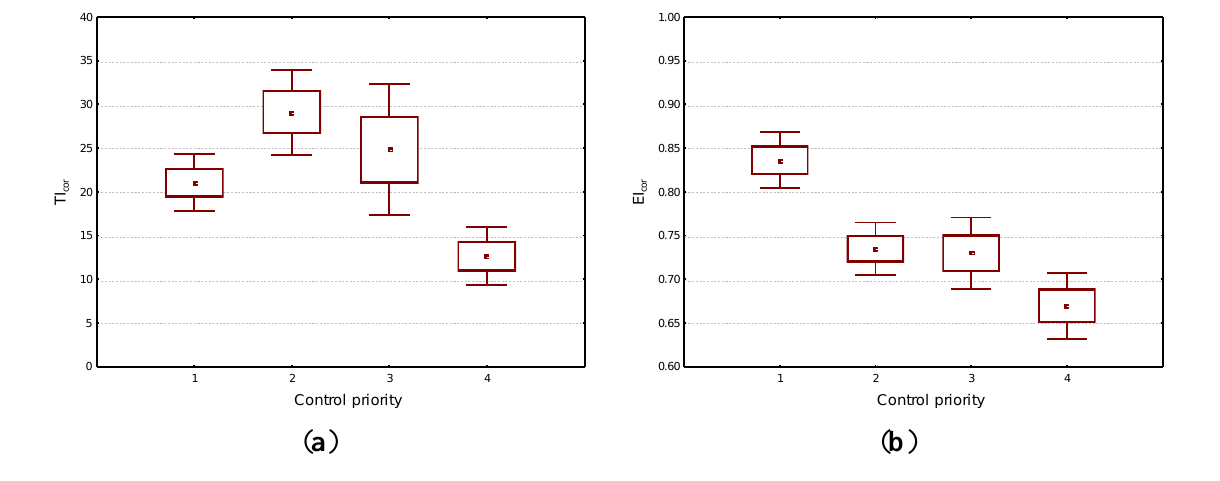
Figure 5. The predicted ratings for ( a ) toxicity index (TI), ( b ) exposure index (EI), ( c ) management index (MI), and ( d ) protection index (PI) for the four control priority industries using a whisker plots (the square dot inside the box is the mean, the bottom and top of the box are mean ± standard error (SE), and whiskers of the both ends are mean ±